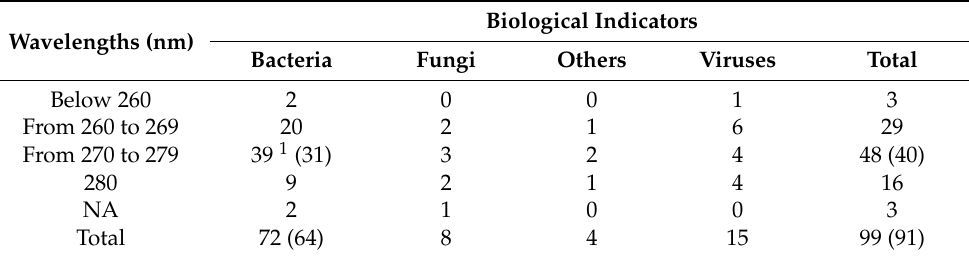
Table 3. Wavelengths according to the decontaminated biological indicators. Biological Indicators Wavelengths (nm) Bacteria Fungi Others Viruses